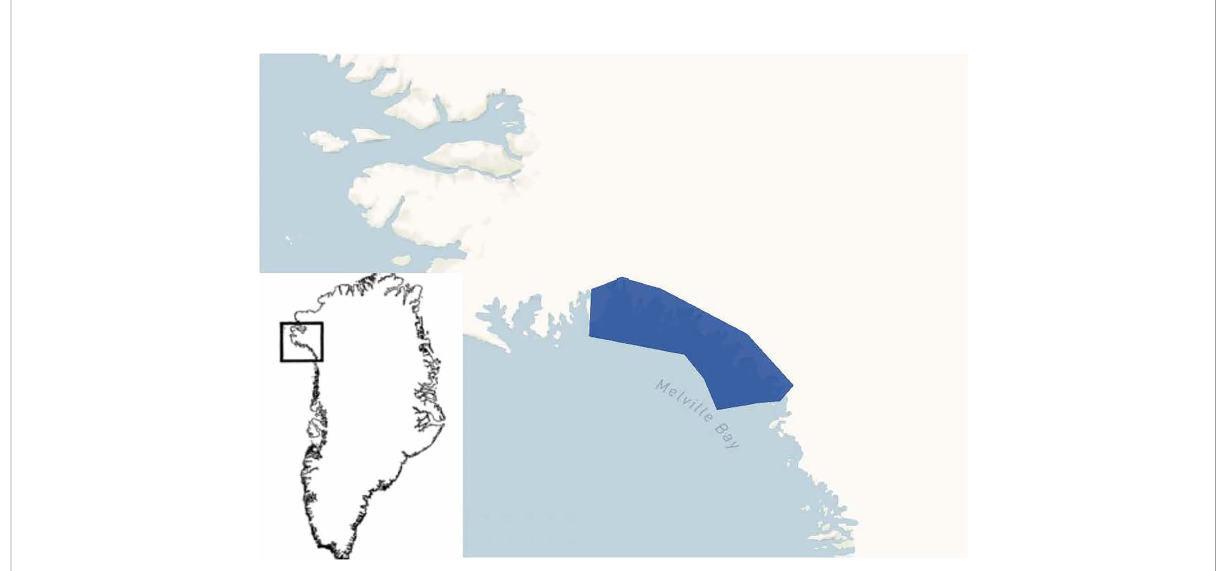
FIGURE 7 Map of Melville Bay. Source: UNEP-WCMC and IUCN, 2022.